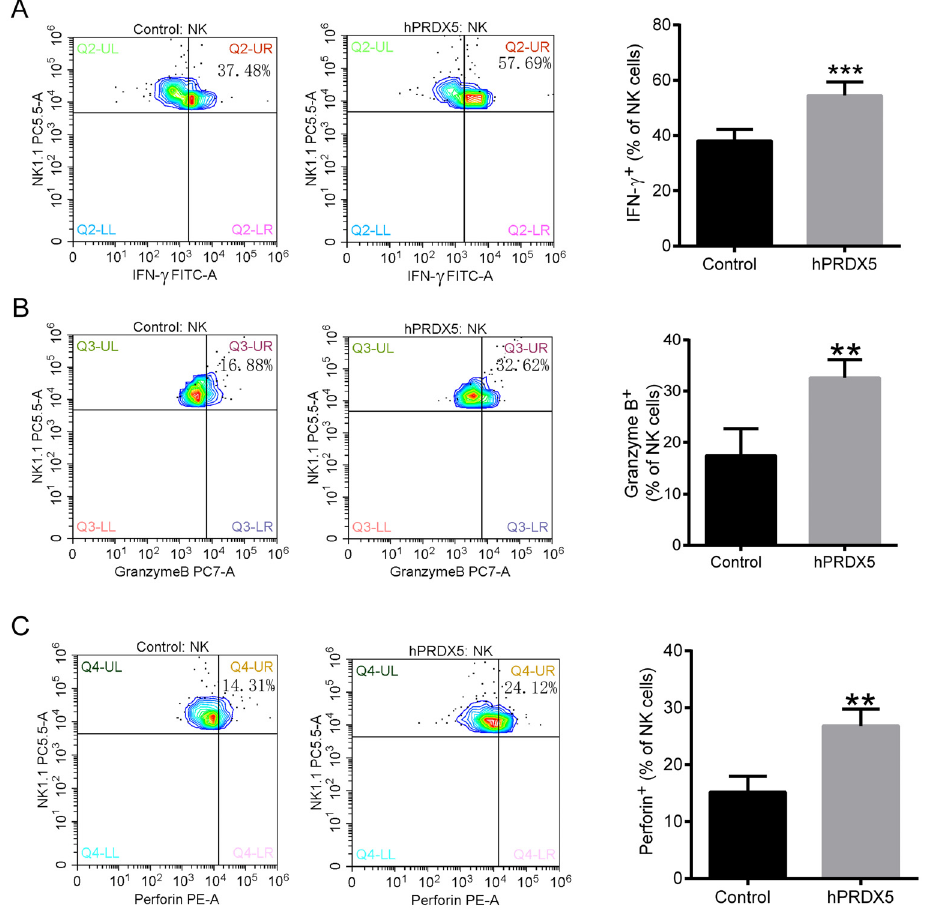
Figure 5. Effect of human peroxiredoxin-5 (hPRDX5) on the expression of function proteins of natural killer (NK) cells in tumor tissues. The levels of IFN- g ( A ), granzyme B ( B ), and perforin ( C ) in NK cells in the control and hPRDX5 treatment groups. Data are reported as means ± SD. **P o 0.01 and ***P o 0.001 compared with the control ( t